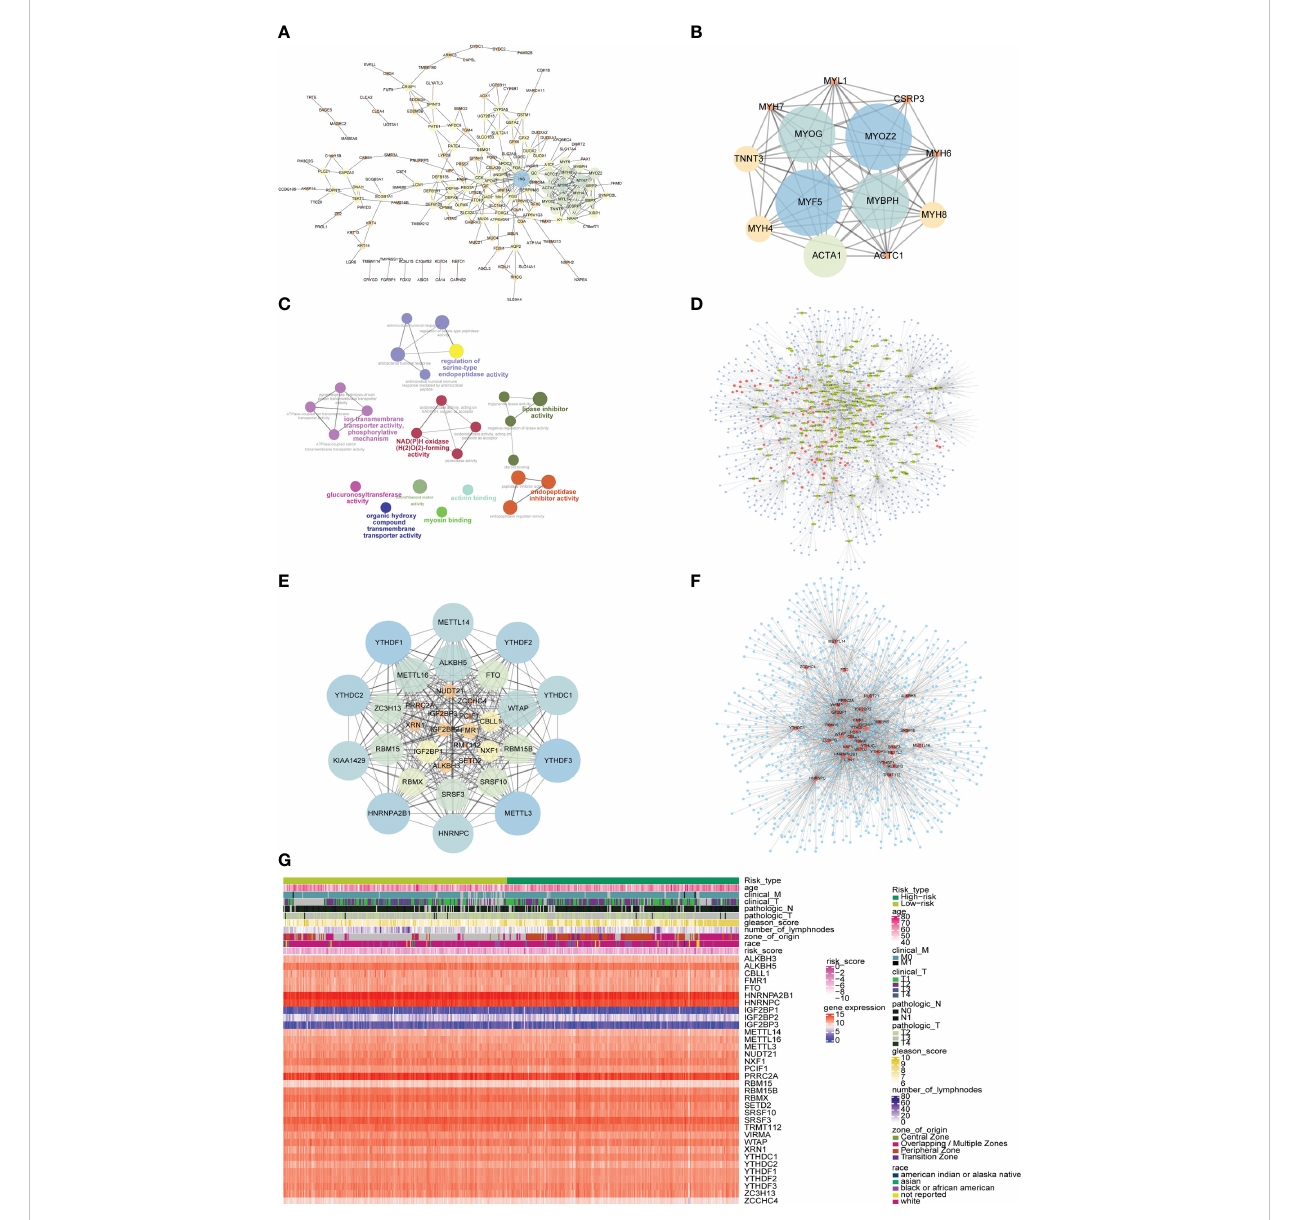
FIGURE 11 PPI network and mRNA-miRNA-lncRNA network of differentially expressed genes. (A) PPI network of differentially expressed genes. The node size represents the degree of the node. (B) The fi rst subnet in the PPI network of differentially expressed gene. The node size represents the score of mcode. (C) Graph of enrichment analysis of PPI network of differentially expressed gene. (D) mRNA-miRNA-lncRNA network of differentially expressed genes. Blue nodes represent miRNAs, red nodes represent differentially expressed lncRNAs, and yellow nodes represent differentially expressed mRNAs. (E) PPI network of m 6 A-related gene. The node size indicates the degree of the node. (F) mRNA-miRNA network of m 6 A-related gene. Blue nodes represent miRNAs, and red nodes represent m 6 A-related genes. (G) The heat map of m 6 A-related genes, risk scores combined with clinicopathological